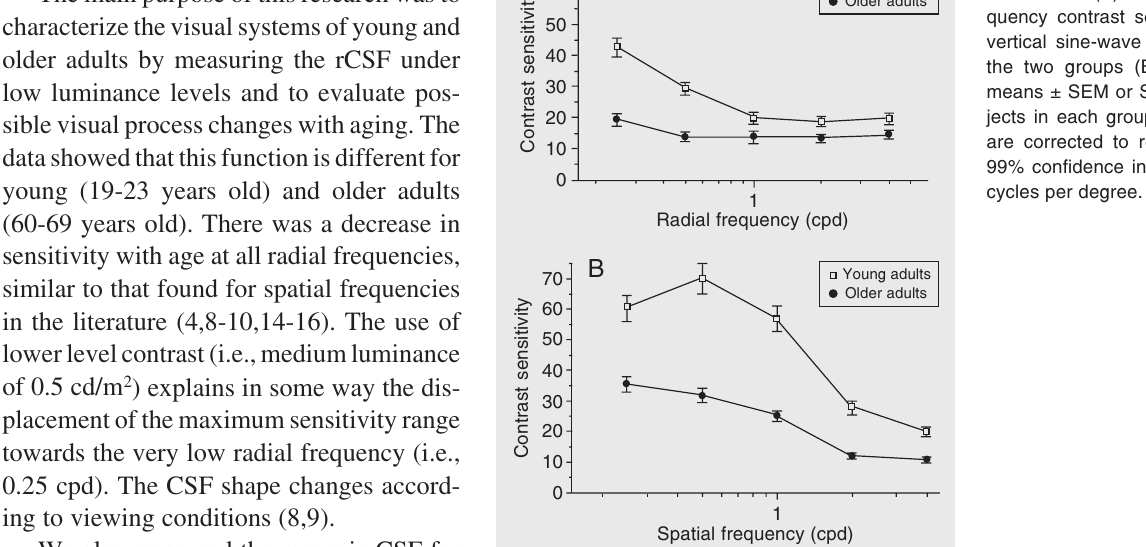
Figure 2. Radial frequency sen- sitivity functions for young and older adults (A) and spatial fre- quency contrast sensitivity (for vertical sine-wave gratings) for the two groups (B). Data are means ± SEM or SD for 6 sub- jects in each group. Error bars are corrected to represent the 99% confidence interval. cpd = cycles per degree.